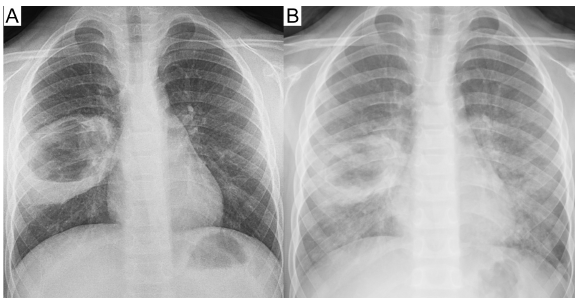
Figure 3. a,b. In a 7-year-old male who presented with cough and hydatoptysis, chest x-ray (a) taken at the time of admission and chest x-ray showing bilateral diffuse pneumonia 2 days after the perforation (b) are